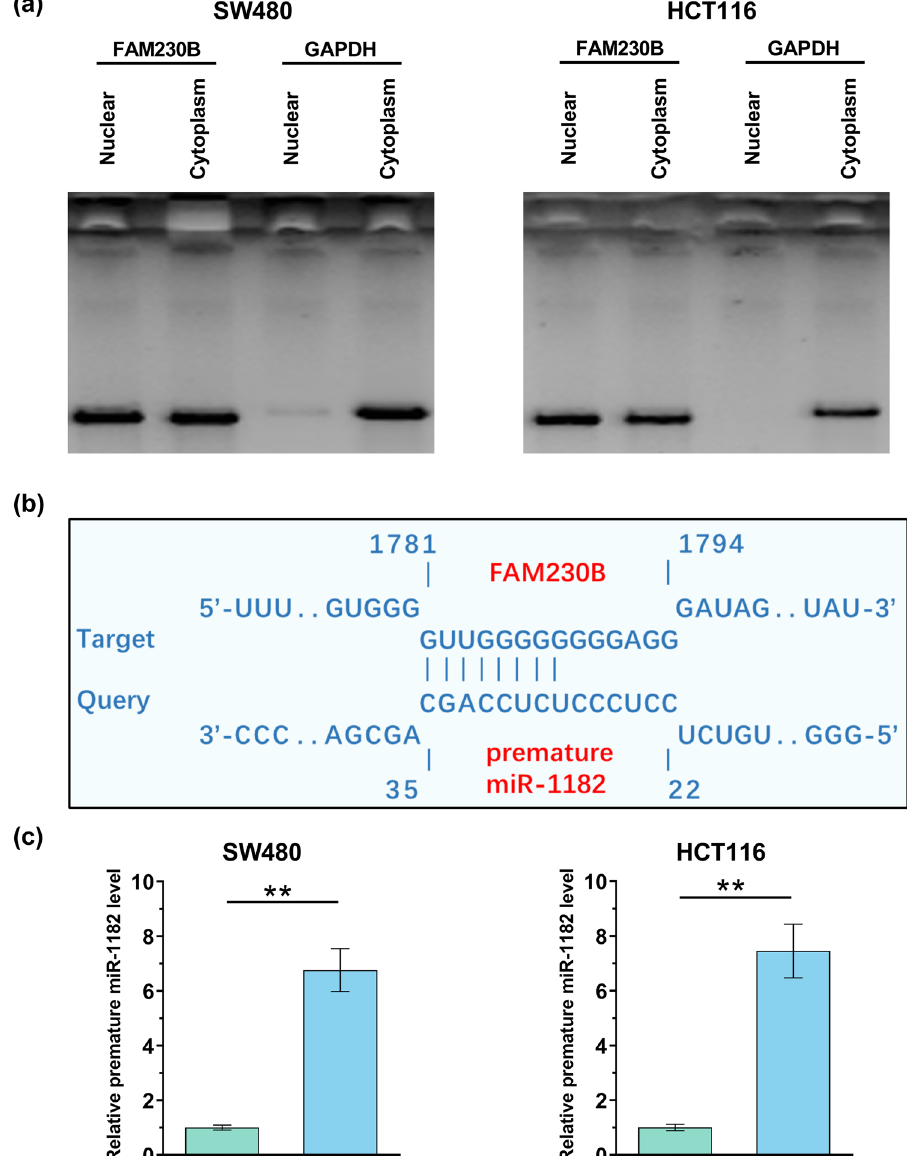
Figure 2: The subcellular location of FAM230B and its interaction with miR - 1182. SW480 and HCT116 cells were subjected to the preparation of nucleus and cytoplasm samples, which were subjected to RT - qPCR to determine the expression of FAM230B ( a ) . IntaRNA 2.0 was applied to predict that the base pairs could be formed by FAM230B and miR - 1182 ( b ) . The direct interaction between them was con fi rmed by RNA - RNA pull - down assay ( c ) . ** p <